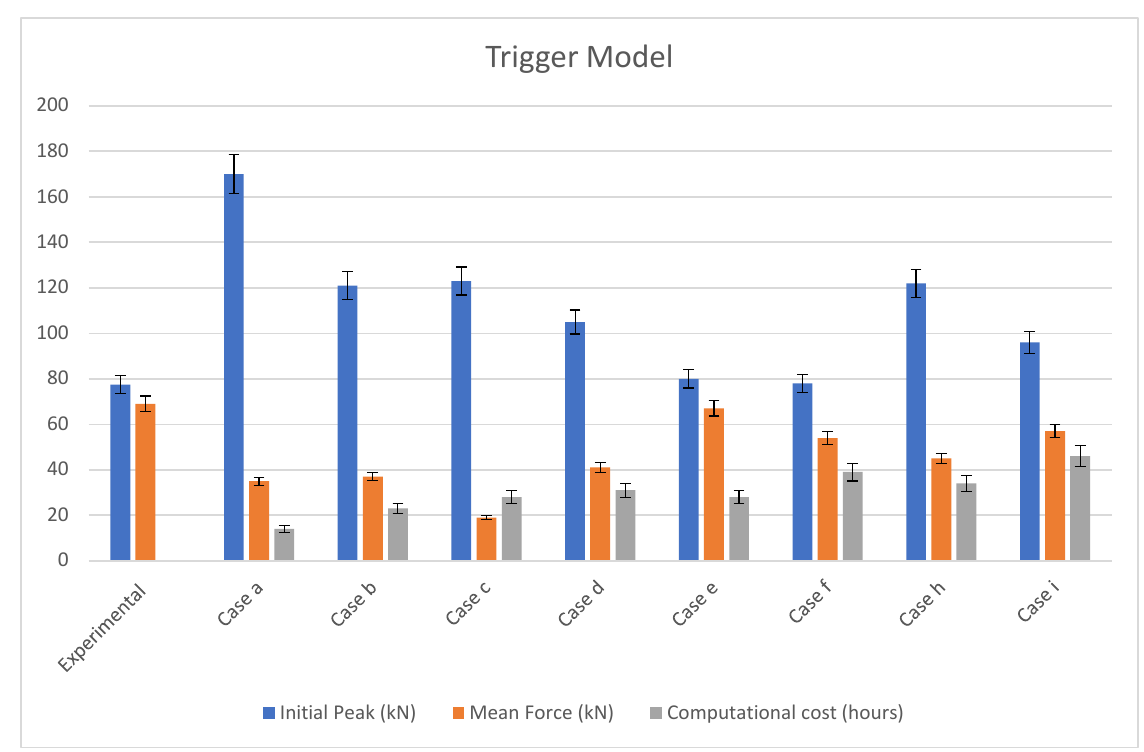
Figure 9. Trigger model comparison [66].